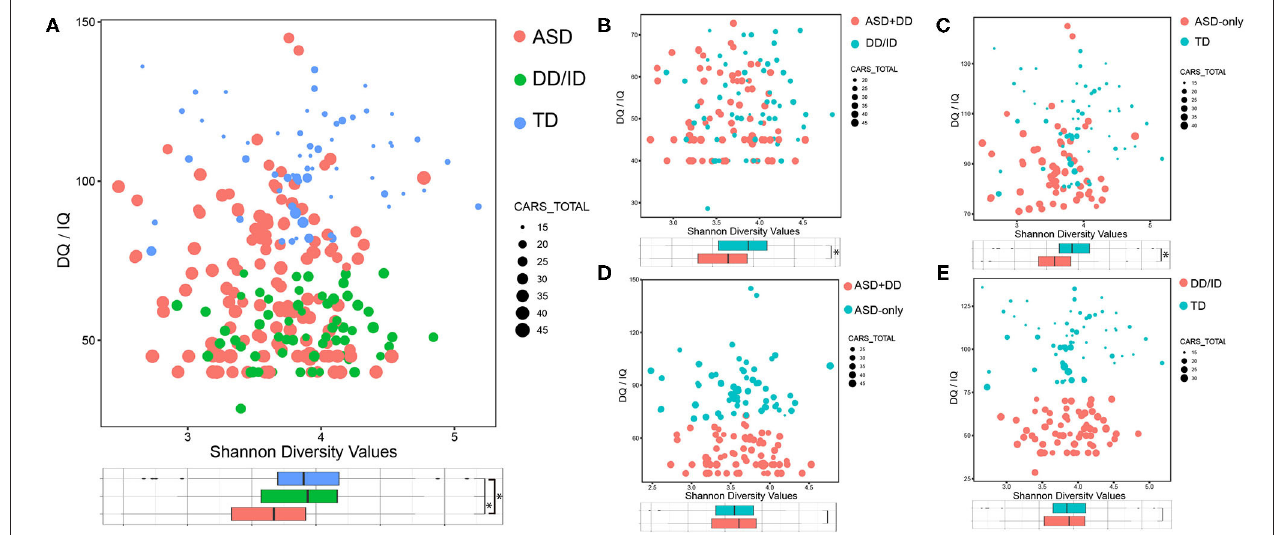
FIGURE 2 | Bacterial richness and diversity comparison according to the Shannon index depicted with IQ/DQ and CARS total scores. The size of node is proportional to the number of CARS total scores. The color of node indicates different groups. * p < 0.05. (A) ASD vs. DD/ID vs. TD. (B) ASD + DD vs. DD/ID. (C) ASD-only vs. TD. (D) ASD + DD vs. ASD-only. (E) DD/ID vs. TD. ASD, autism spectrum disorder; DD/ID, developmental delay or intellectual disability; TD, typically developing; CARS, Childhood Autism Rating Scale.